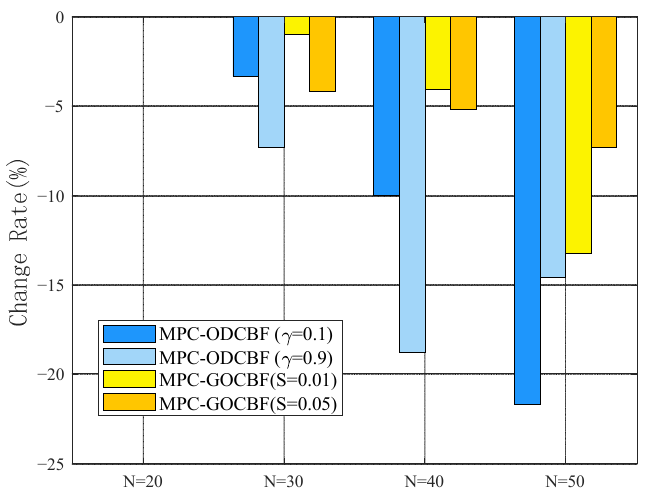
Figure 10. The change rate of our MPC-GOCBF with MPC-ODCBF as the number of dynamic obstacles N increases from 20 to 50, with N = 20 as the base.